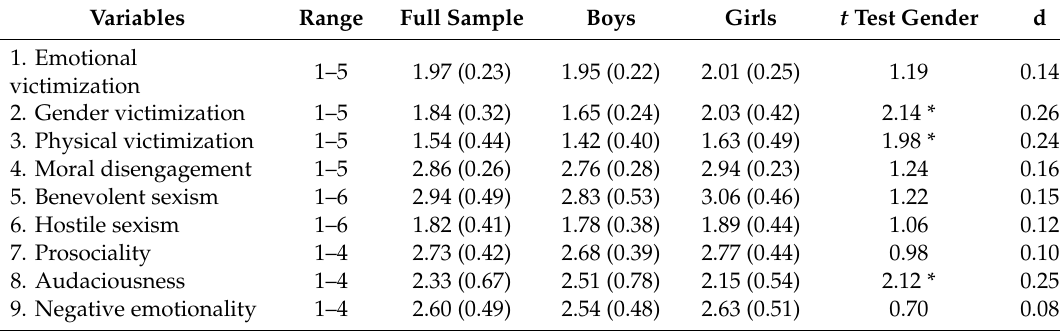
Table 1. Statistical descriptions according to gender.